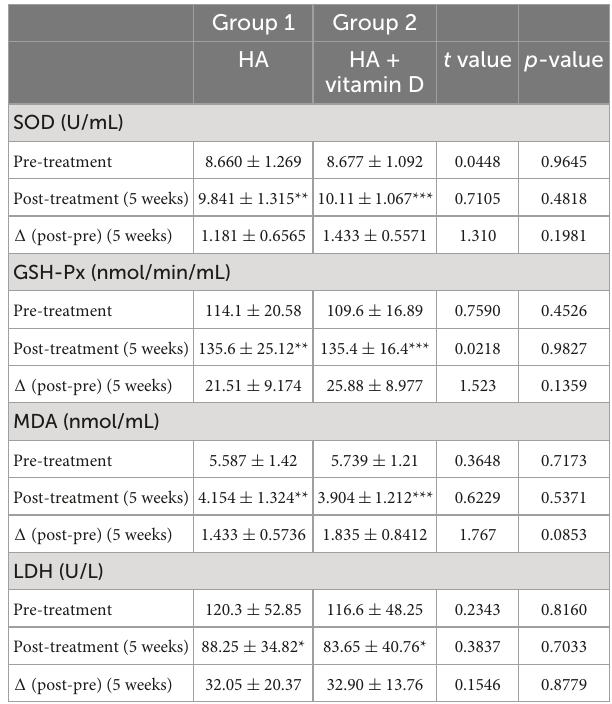
TABLE 5 Effect of HA injection with or without vitamin D supplementation on synovial fluid OS.